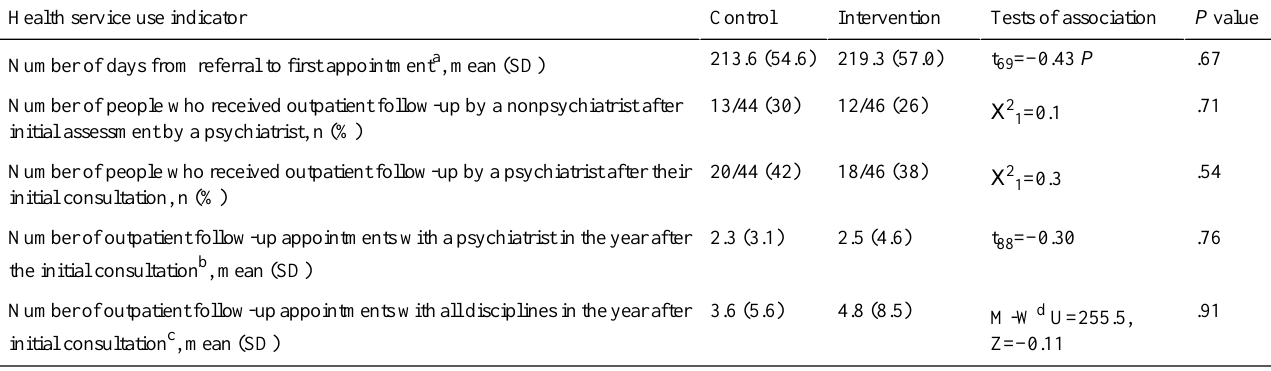
Table 8. Hospital service use.